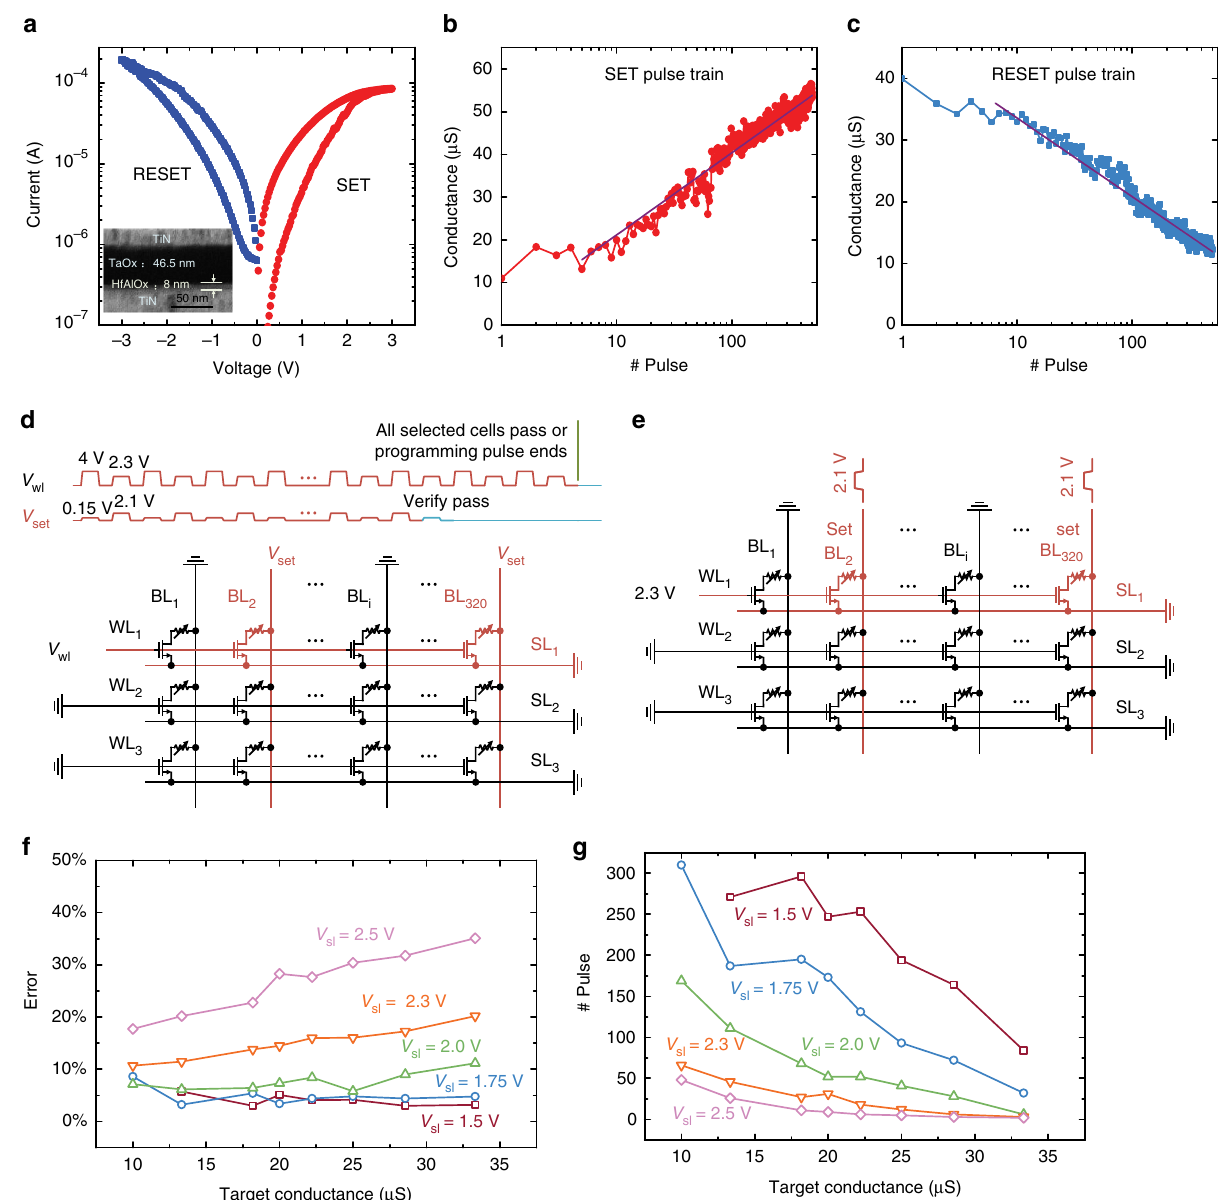
Figure 3 | The performance of the optimized device and two examples for programming. ( a ) Typical I – V curve of a single 1T1R cell for a quasi-DC sweep, the gate voltage is 1.8 and 8V during SETand RESETprocess, respectively. Inset is a transmission electron microscope (TEM) image of the RRAM device. ( b ) An example of the typical continuous conductance tuning performance under an identical pulse train condition during SETprocess, along with the fitting curve. V wl ¼ 2.4V, V bl ¼ 2.0V (50ns), V sl ¼ 0V. ( c ) Tuning performance during RESEToperation, along with the fitting curve. V wl ¼ 8V, V bl ¼ 0V, V sl ¼